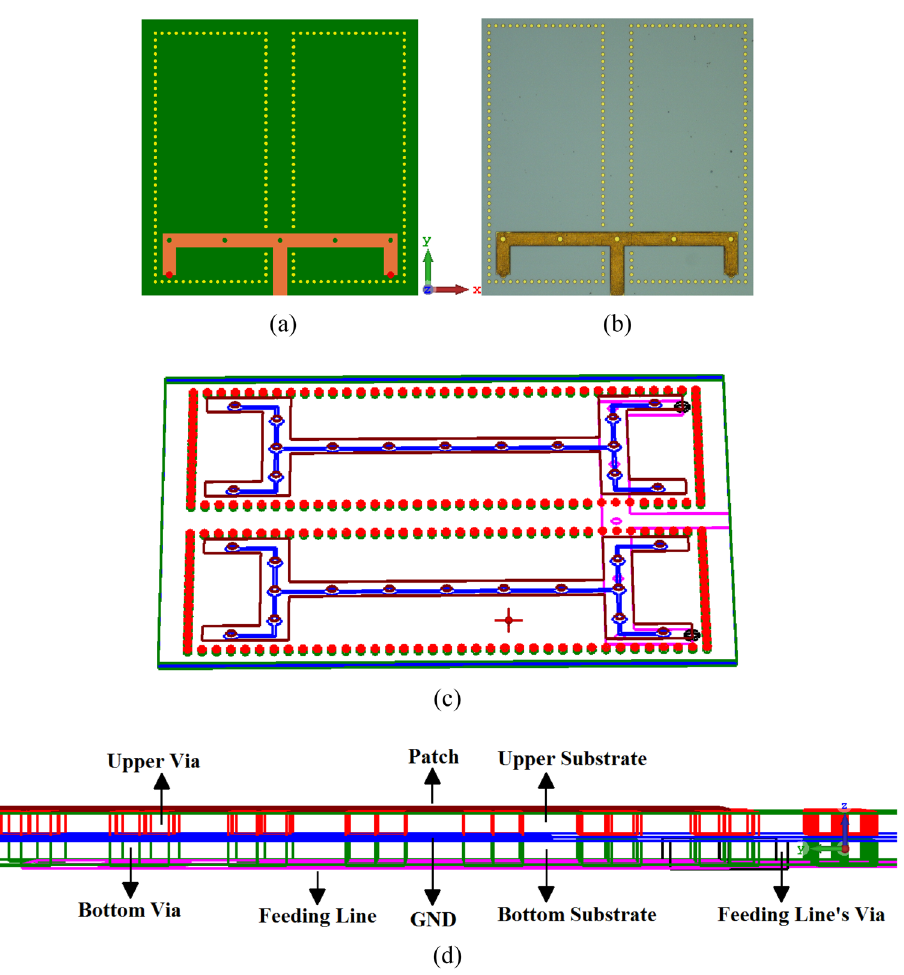
Figure 8. ( a ) Layout of the SIW-MTS inspired AoC with MTS short-circuited feedline, ( b ) fabricated GaAs prototype, ( c ) illustration showing positions of the metallic post wall around the wrench-shaped radiators and the ground-plane slots, and ( d ) cross-sectional view of the antenna’s five stacked layers.